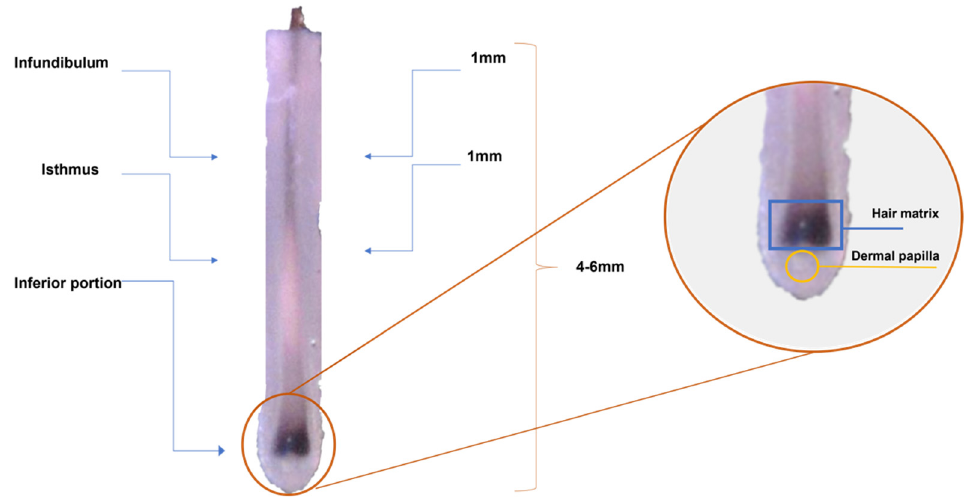
Figure 7. Stereomicroscopic view of the anatomy of an anagen hair follicle.